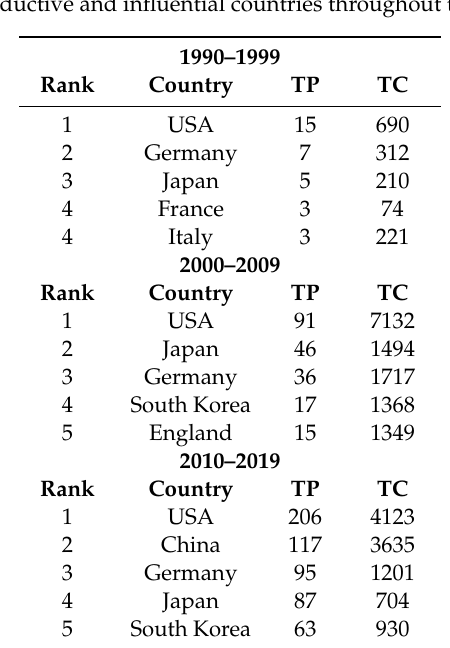
Table 3. Most productive and influential countries throughout time for topic set 3.